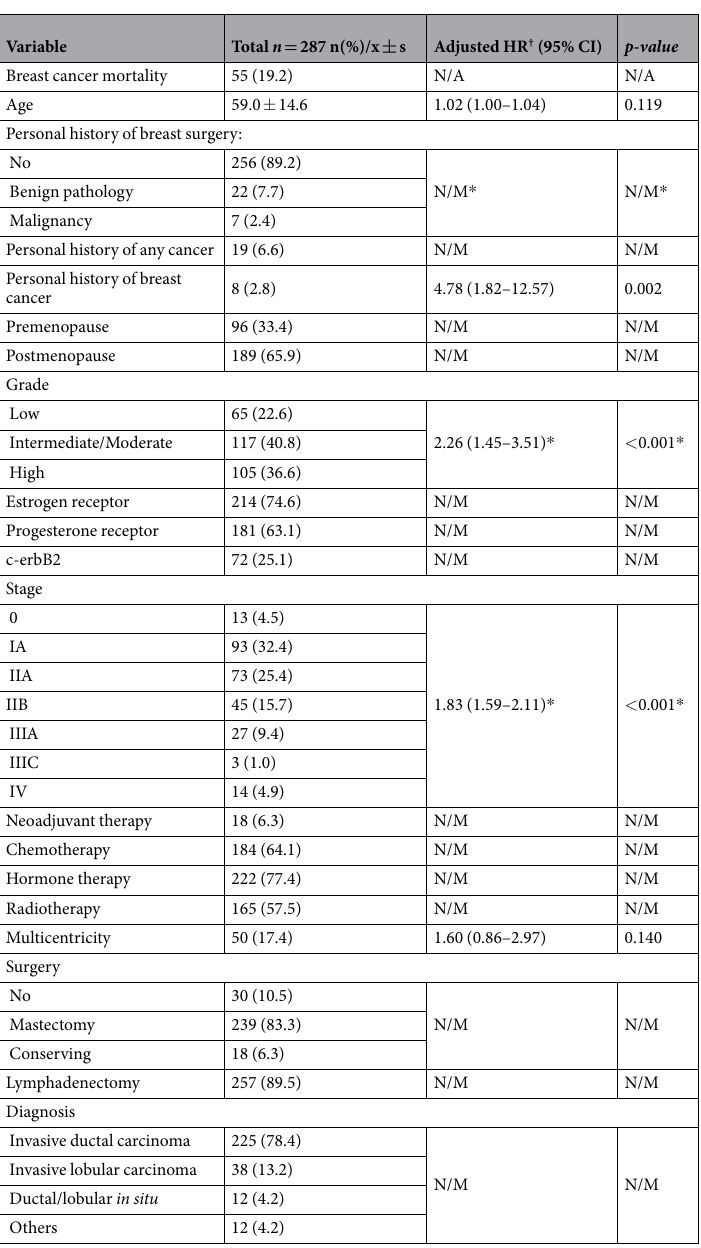
Table 2. Descriptive characteristics and adjusted hazard ratios for predicting breast cancer mortality. CI, confidence interval; HR, hazard ratio; n(%), absolute frequency (relative frequency); N/A, not applicable; N/M, not in the multivariate model; x ± s, mean ± standard deviation. * Analyzed as a quantitative variable; † the variables in the multivariate model are those with HR. Goodness-of-fit of the model: χ 2 = 165.1, p < 0.001, C-statistic = 0.85 (standard error